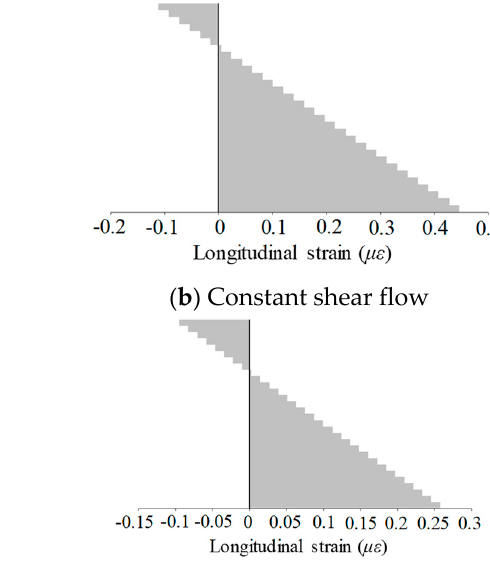
Figure 11. Placas and Regan Beam (T1 specimen).